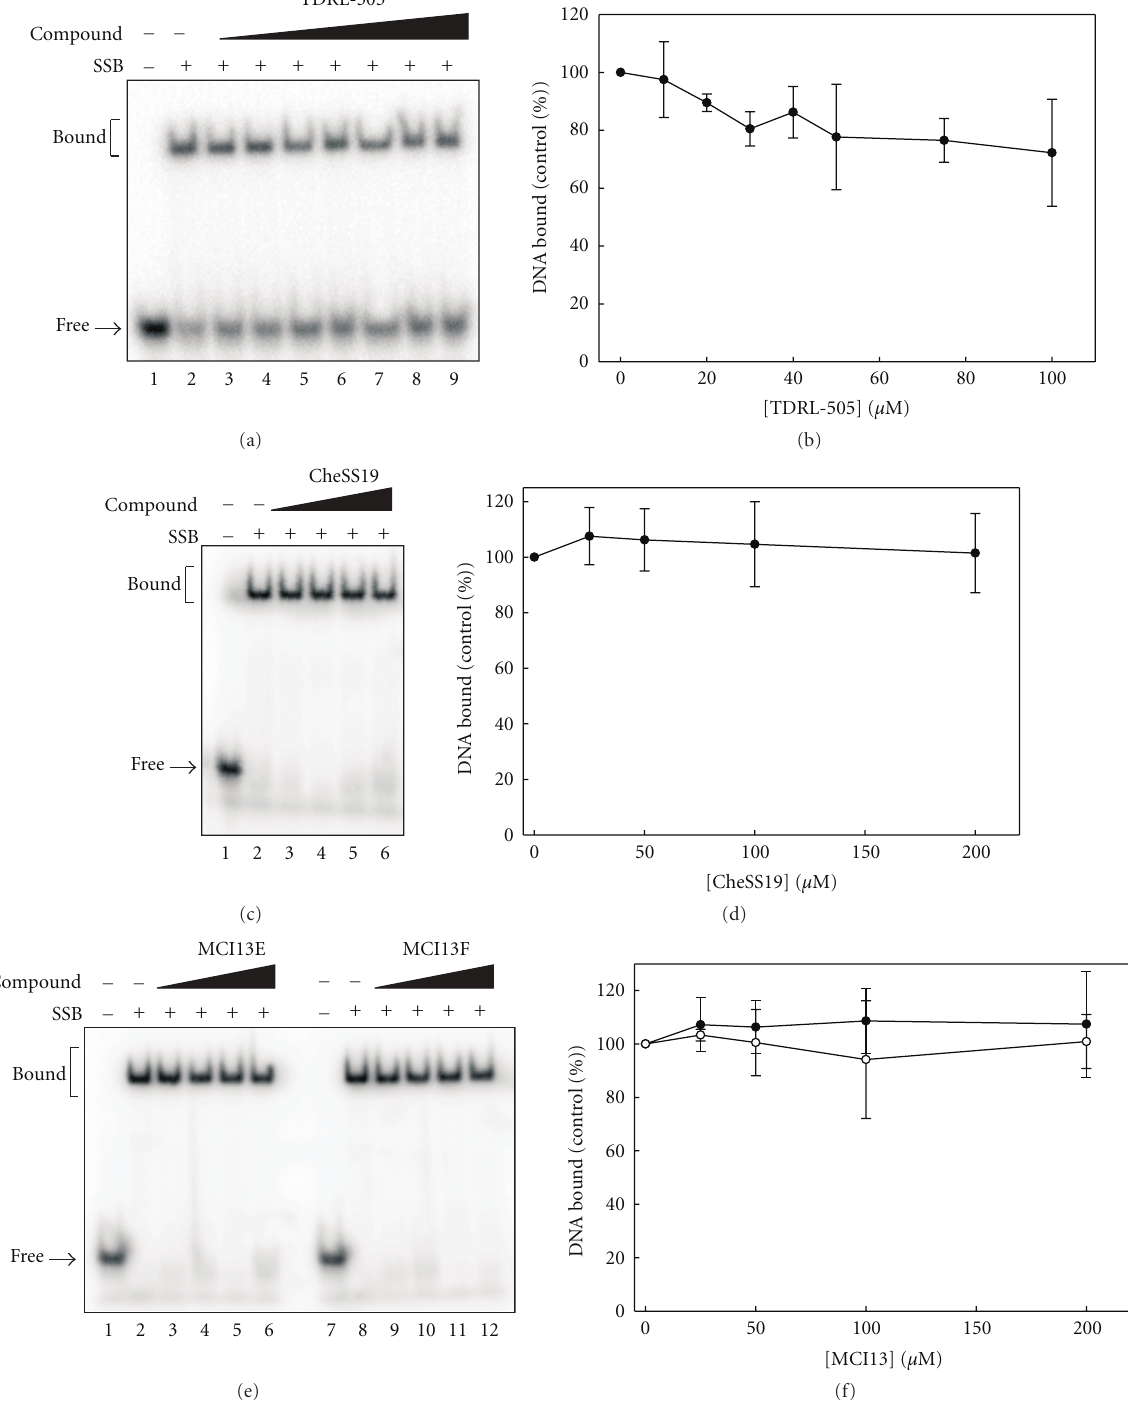
Figure 6: Ec SSB protein-ssDNA interaction is not a ff ected by the RPA inhibitors. (a) Titration of TDRL-505 in Ec SSB DNA-binding reactions. TDRL-505 (0, 10, 20, 30, 40, 50, 75, and 100 μ M) was preincubated with Ec SSB, and binding to a 30-base pair ssDNA was assessed by EMSA as described in “Section 2.” (b) Analysis of TDRL-505 inhibition of Ec SSB. The average of three independent experiments is presented with SD. (c) CheSS19 titration in Ec SSB DNA-binding reactions. CheSS19 (0, 25, 50, 100, and 200 μ M) was preincubated with Ec SSB, and binding reactions were carried out as in (a). (d) Analysis of CheSS19 inhibition of Ec SSB. The average of three independent experiments is presented with SD. (e) Titration of MCI13E and MCI13F in Ec SSB DNA-binding reactions. Concentrations of MCI13E/F used were 0, 25, 50, 100, and 200 μ M. (f) Analysis of MCI13E/F inhibition of Ec SSB. The average of three independent experiments is presented with SD. Data for MCI13E is shown as filled circles, and MCI13F is shown as open circles. In panels (a), (c), and (e), the “Free” ssDNA is indicated with an arrow, and the “Bound” ssDNA is indicated by brackets. All reactions were performed in the same order and manner as the RPA-binding